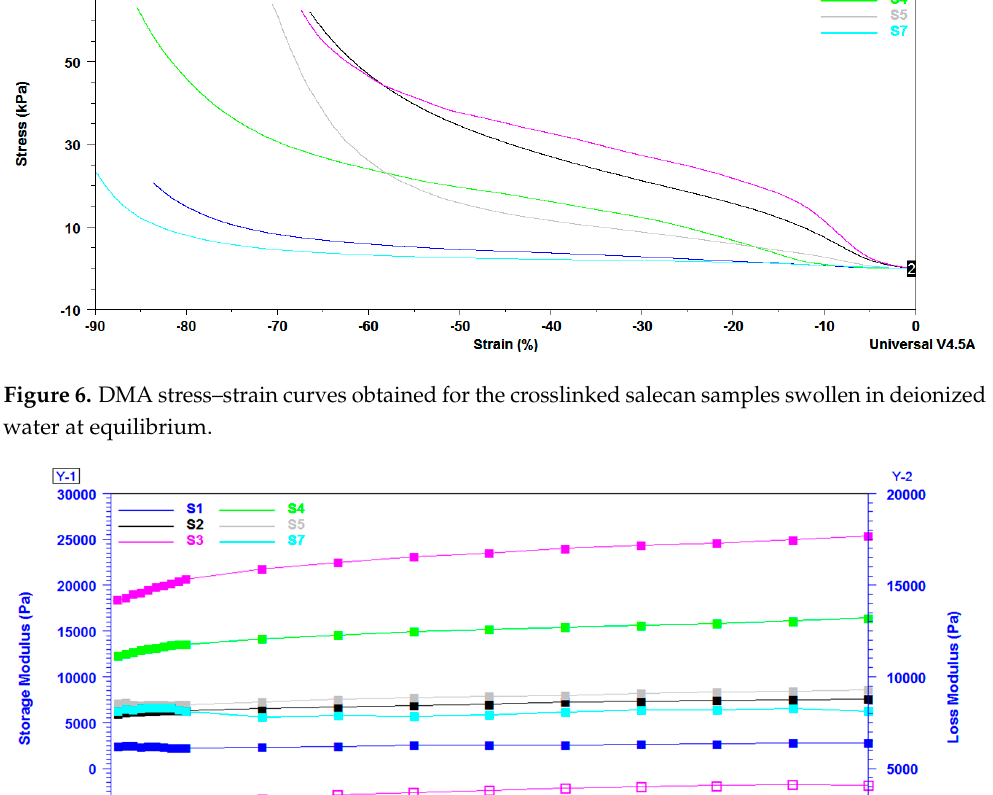
Figure 8. Antimicrobial activity against Escherichia coli (left side) and Staphylococcus aureus (right side). The difference between the two values of the degree of inhibition for the two types of bacteria tested can be given by the structure of the cell wall. Escherichia coli is a Gram-negative bacterium, unlike Staphylococcus aureus , which is a Gram-positive bacte- rium with a more resistant cell wall due to the basic unit. Table 3. The evaluation of the antimicrobial activity of the citrate-salecan samples. Sample